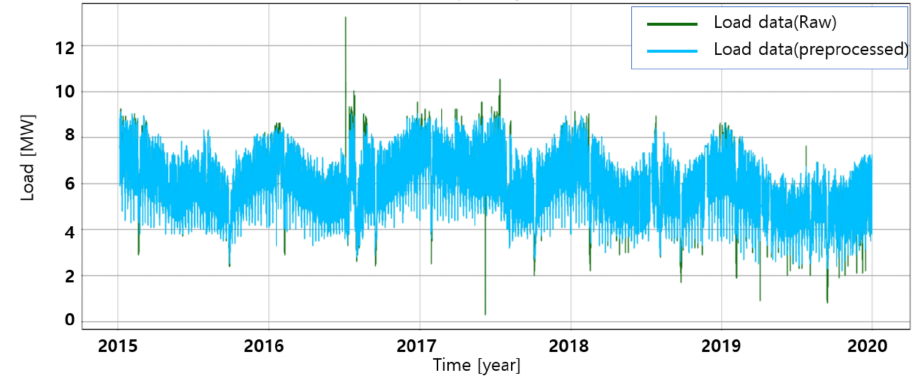
Figure 9. Example of the final preprocessing